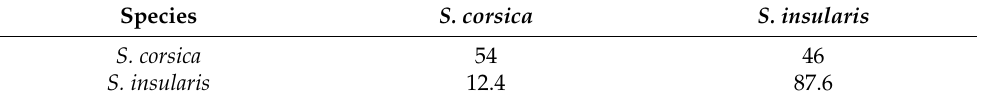
Table 6. Cypsela morpho-colorimetric analysis of Santolina corsica and S. insularis . Confusion matrix of the LDA analysis applied comparing the current taxonomic hypothesis. Values are percentages.